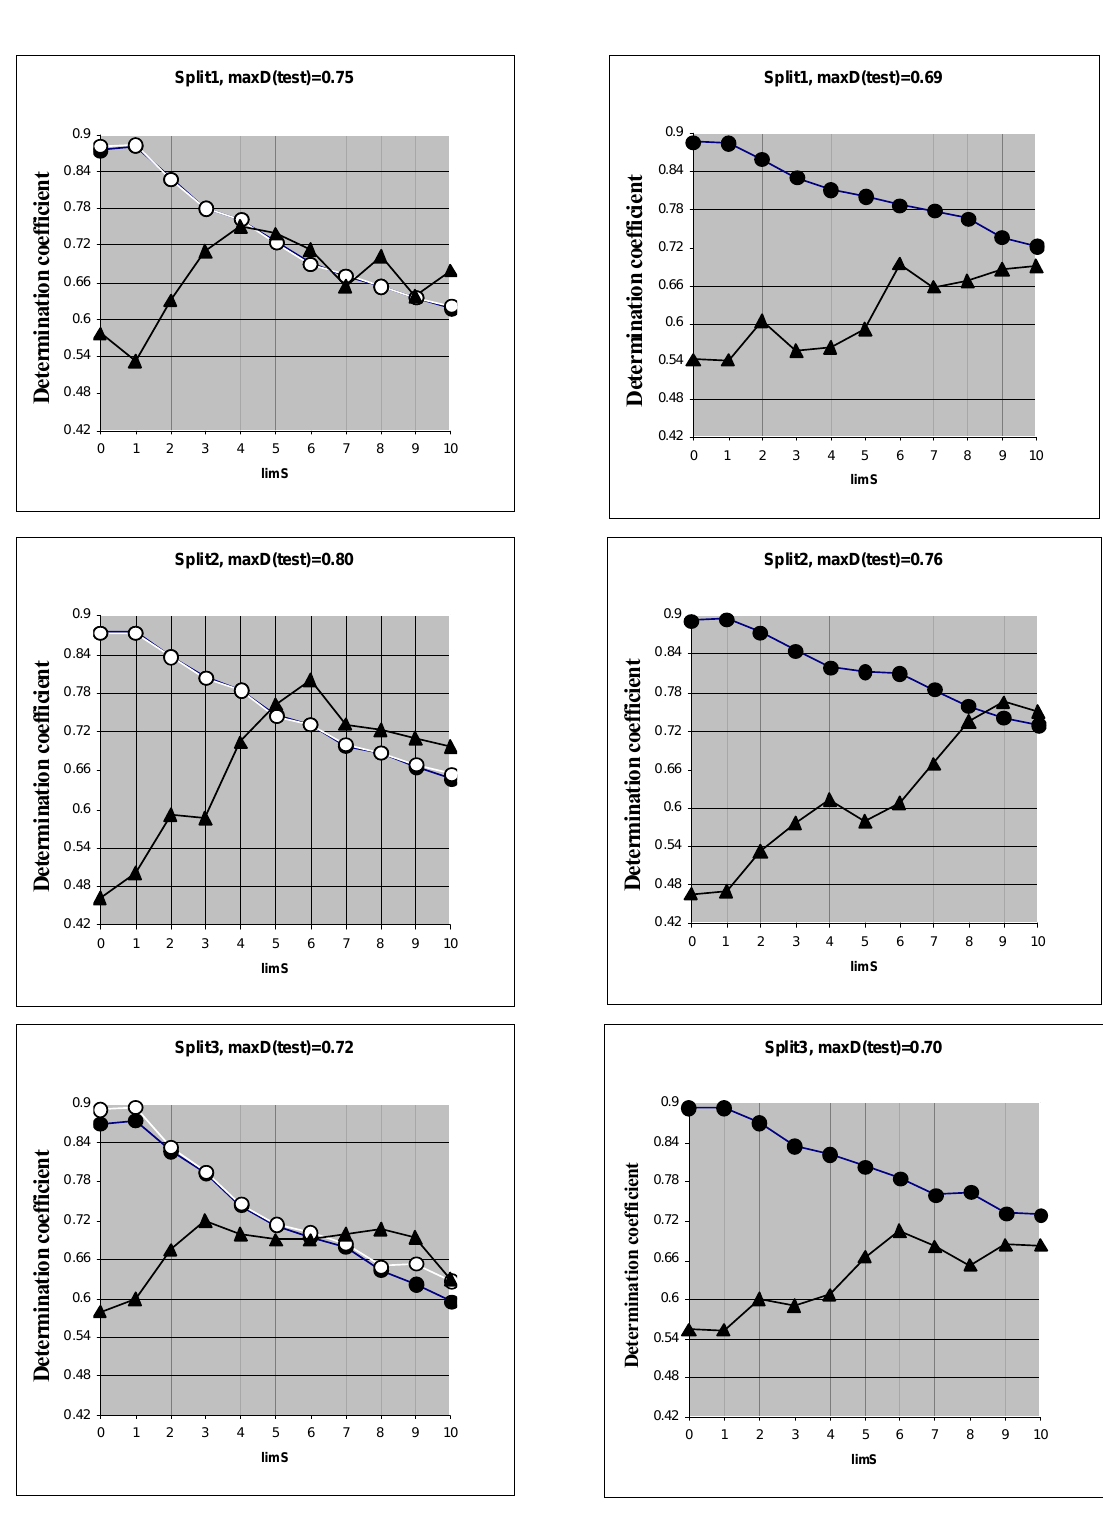
Figure 3. Comparison of the [subtraining-calibration-test] system and the [training- test] system for three